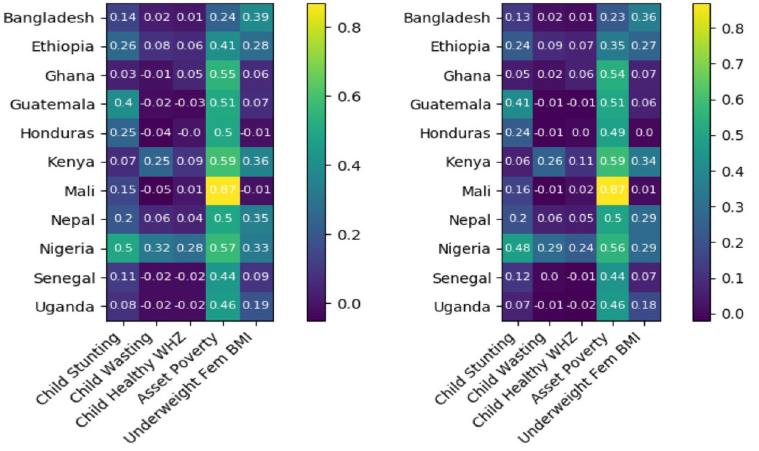
Fig 4. r 2 for contemporaneous poverty and malnutrition prevalence prediction by country. (Left) Independent RF (Right) MRF.